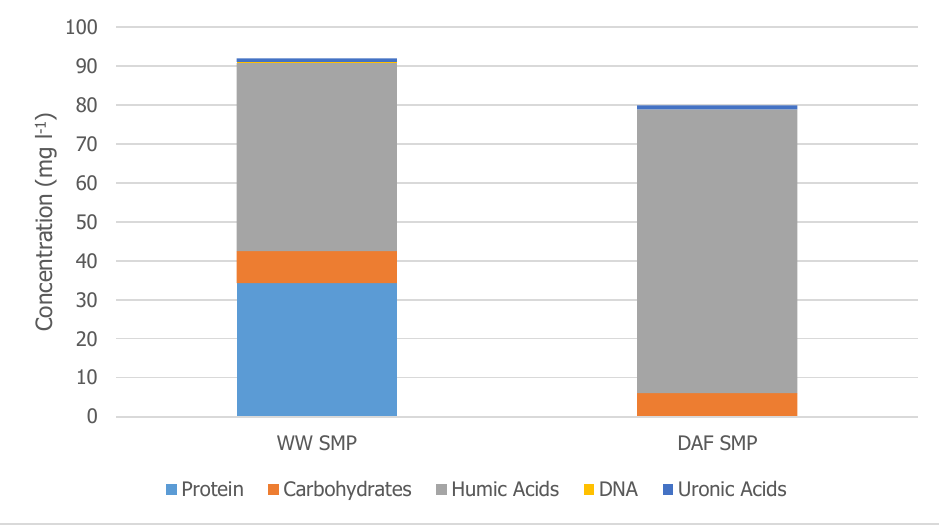
Figure 6. EPS Composition of Waste Activated Sludge and DAF Float. 4. Conclusions The experiments herein have shown that extending CER extraction time increases the amount of EPS extracted. The 24-h extraction time extracted 3.5 times more EPS than the 0.75-h extraction time, which is the commonly used extraction time in the literature. This was true for all of the main EPS components, including carbohydrates, proteins, humic acids, and DNA, except uronic acids. Lipid concentrations were undetectable in the CER- extracted material. The experiments also indicate that humic acids are extracted more slowly than other EPS components. The amount of DNA in the total EPS for all thee ex- traction times remained low (2–3%) which indicated that minimal cellular rapture oc- curred during the extraction. The literature estimates that EPS may represent about 50% of the VSS in AS. With the CER extraction time of 45 min, the EPS extracted herein was only 9% of the VSS, and with a 24-h extraction time, the EPS extracted was almost 32%. Additional extraction time or different additional extraction methods may be necessary in order to approach the 50% of VSS estimation. The assumption that larger WAS EPS concentrations lead to greater organic matter removal during biosorption has been confirmed. The results show that between 45 and 75